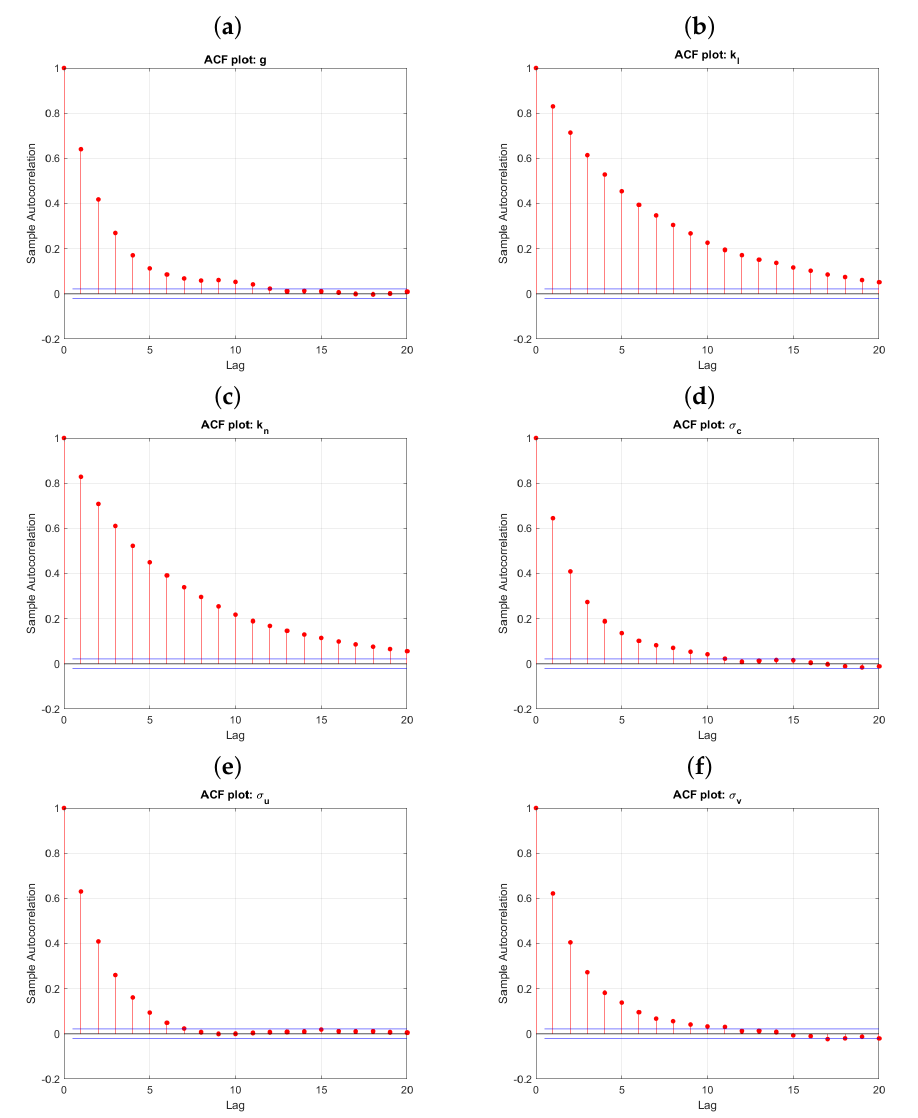
Figure A2. Example autocorrelation plots from the MCMC samples: g (panel a ), k l (panel b ), k n (panel c ), σ (cid:101) (panel d ), σ u (panel e ), and σ v (panel f